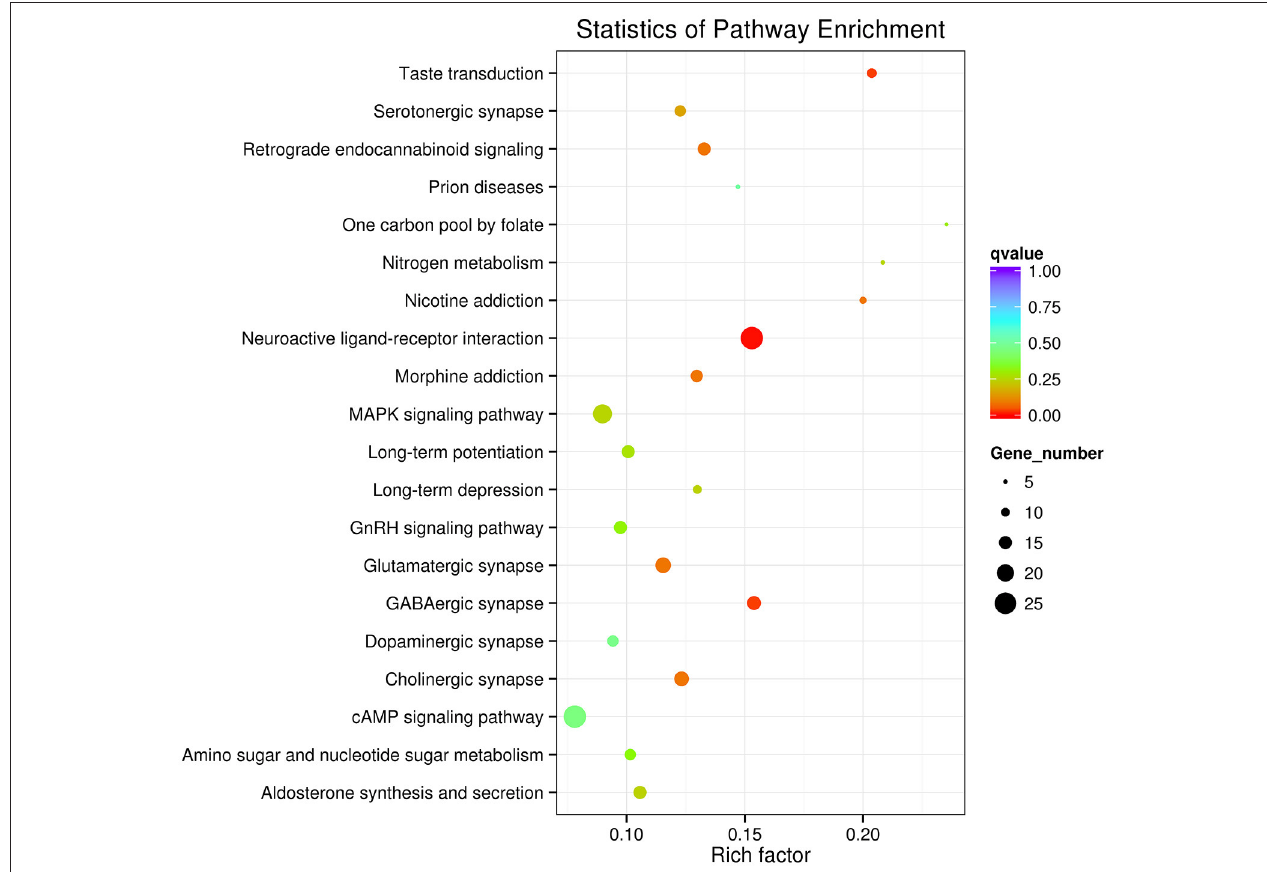
FIGURE 3 | Top 20 enriched Kyoto Encyclopedia of Genes and Genomics (KEGG) pathways of Aphidius gifuensis after the exposure of sublethal does of